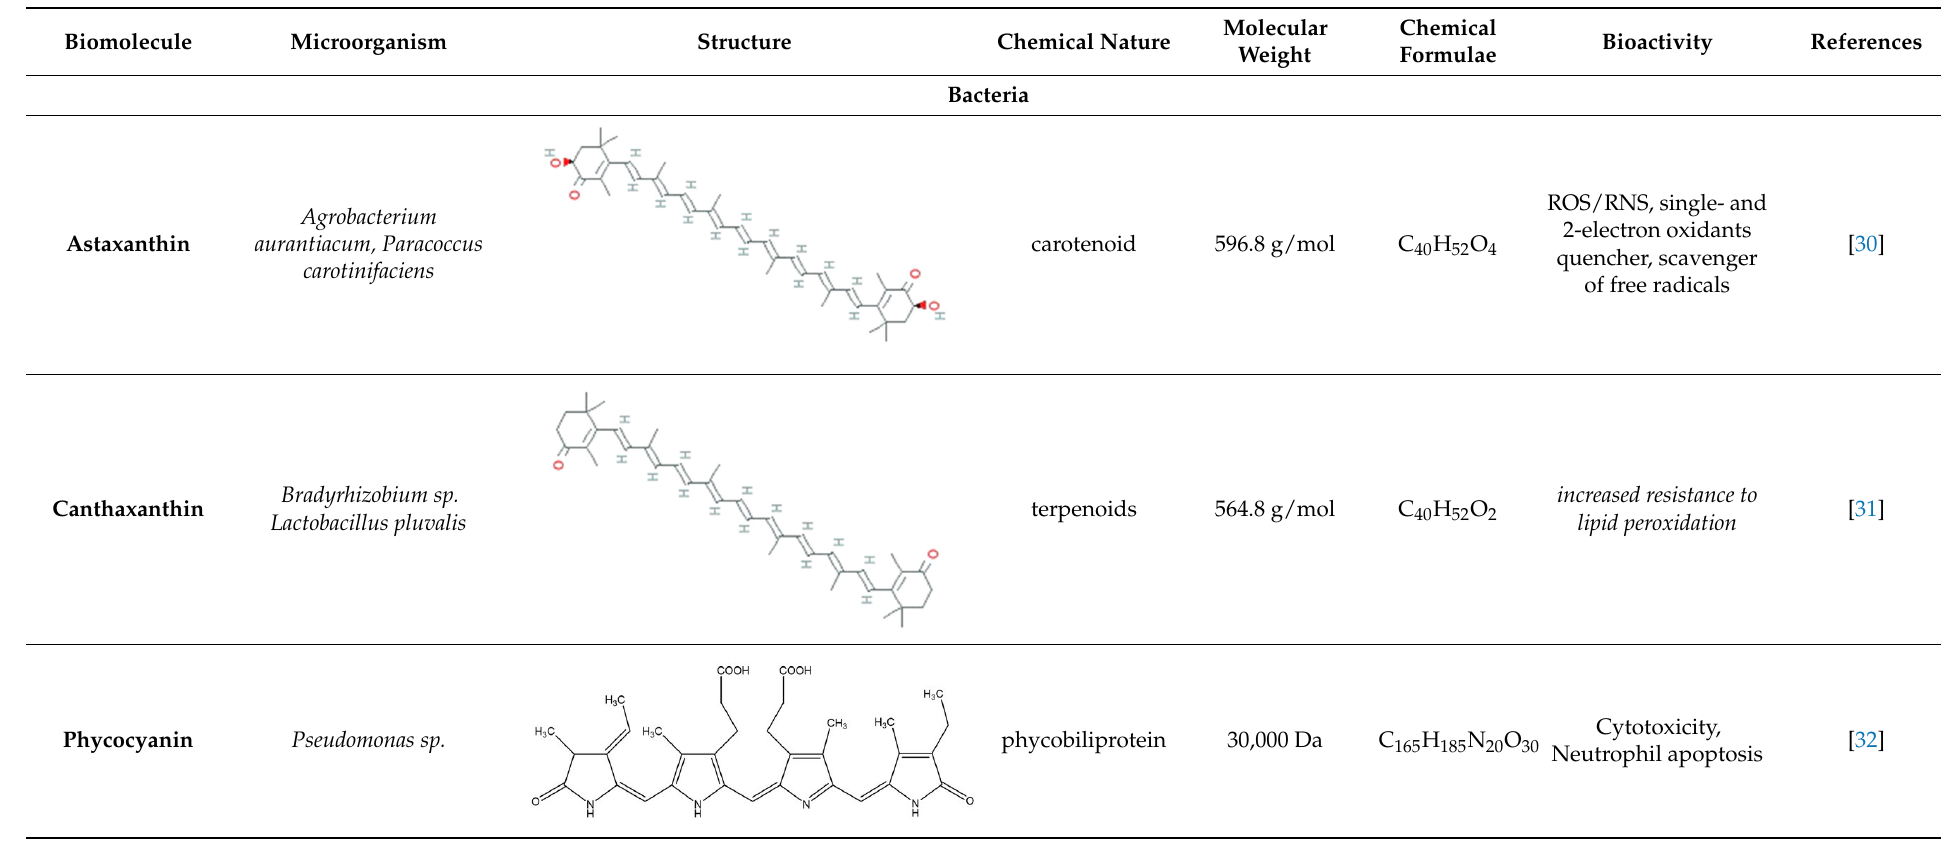
Table 1. Natural microbial antioxidant biomolecules with their chemical nature and bioactivity (Structures are retrieved from [29]).